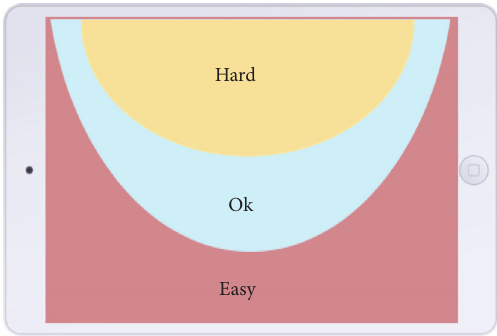
Figure 4: Little Botany UI